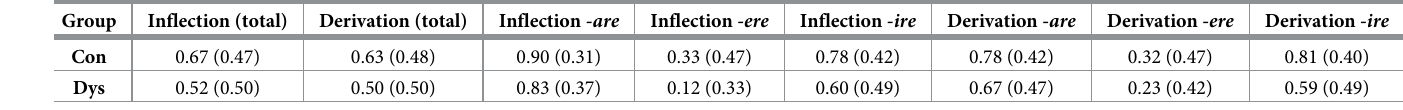
Table 8. Mean accuracy (SDs) of the two groups in inflectional and derivational tasks in the three conjugation classes.